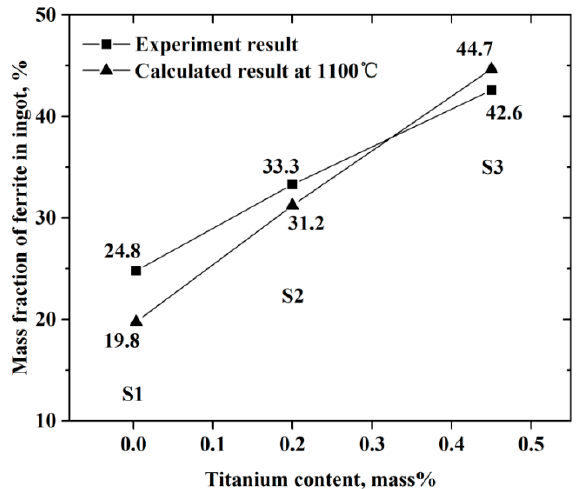
Figure 15. Calculated Ti distribution in phase at di ff erent temperature through equilibrium thermodynamic analysis: ( a ) T A and ( b ) 1100 °C